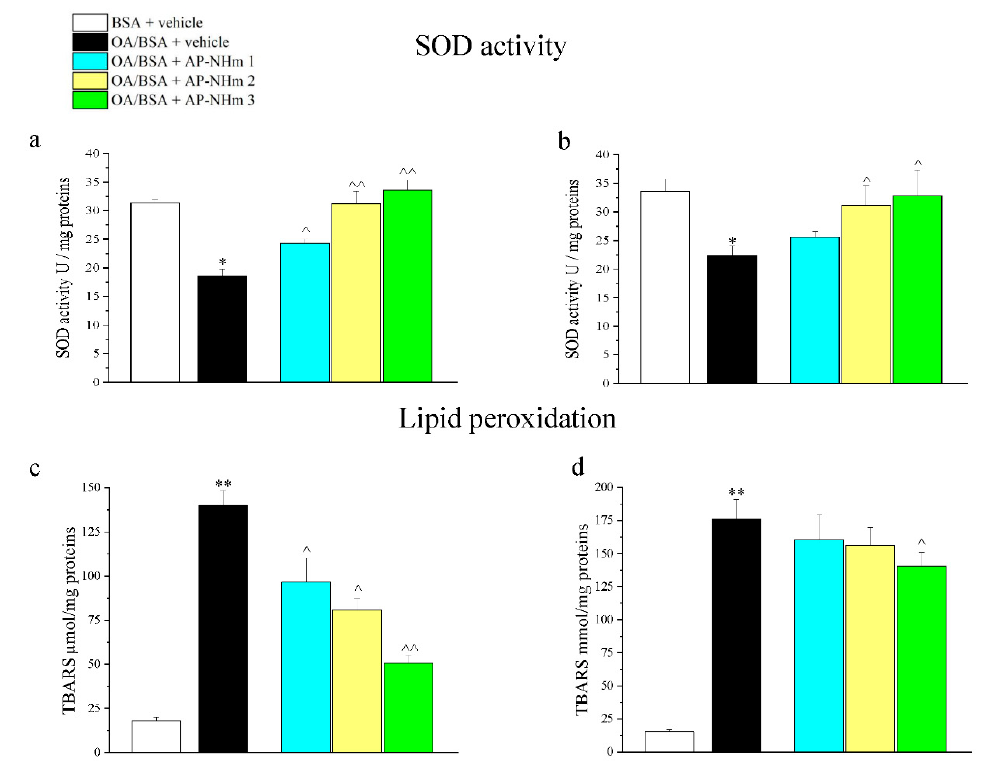
Figure 2. E ff ects of AP-NHm on oxidative damage: superoxide dismutase (SOD) activity in co-treatment ( a ) and post-injury ( b ) regimens; lipid peroxidation in co-treatment ( c ) and post-injury ( d ) regimens. HepG2 were incubated with 0.5-mM oleic acid in 1% BSA(OA / BSA) or BSA alone for 24 h in co-treatment or in post-injury recovery treatment (48 h) with AP-NHm 1, 2, 3. * p < 0.05 and ** p < 0.01 vs. BSA + vehicle, ˆ p < 0.05 and ˆˆ p < 0.01 vs. OA / BSA + vehicle.